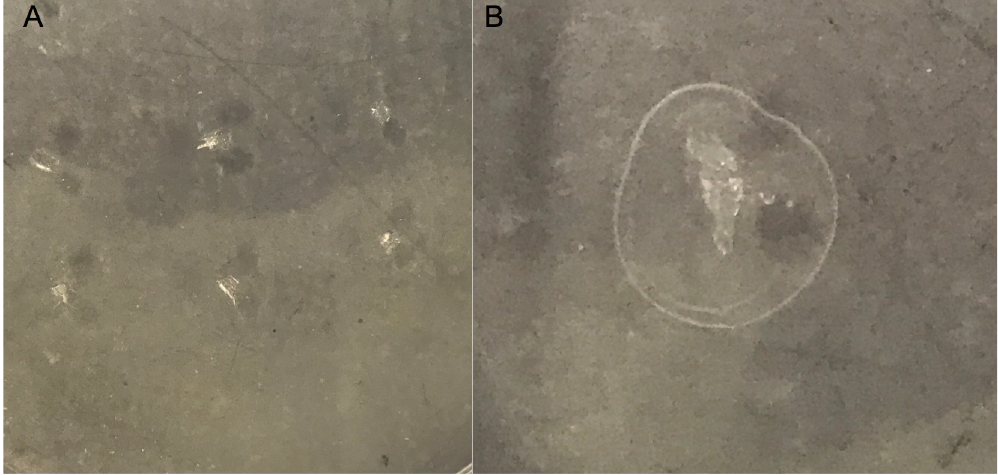
Fig 4. 1% Tween 20 agar plate assay. Results of a 1% Tween 20 agar plate assay at 5 hours exposure to A) polyethylene microparticles B) polyethylene